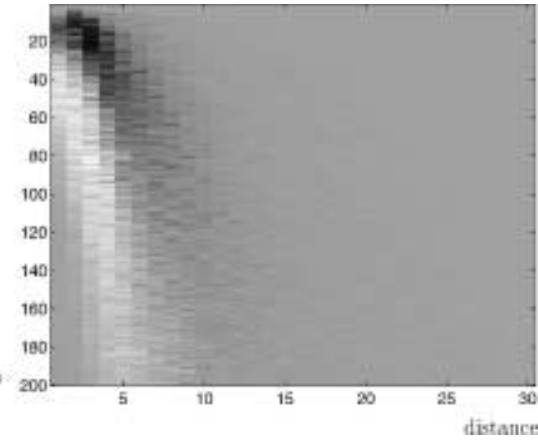
Fig. 10. 2D difference histogram of line length s versus distance in x -direction of the digital curve. This illustrates the difference be- tween the mean normalized histograms extracted from all cells in the good and bad prognosis classes, computed for tolerance T = 3 . 25. The histograms were extracted from the 70% central segment of the monolayer cell nuclei. The lighter area corresponds to line segments that are more probable for the good prognosis class than for the bad prognosis class and the darker area corresponds to line segments that are less probable for the good prognosis class than for the bad prog- nosis